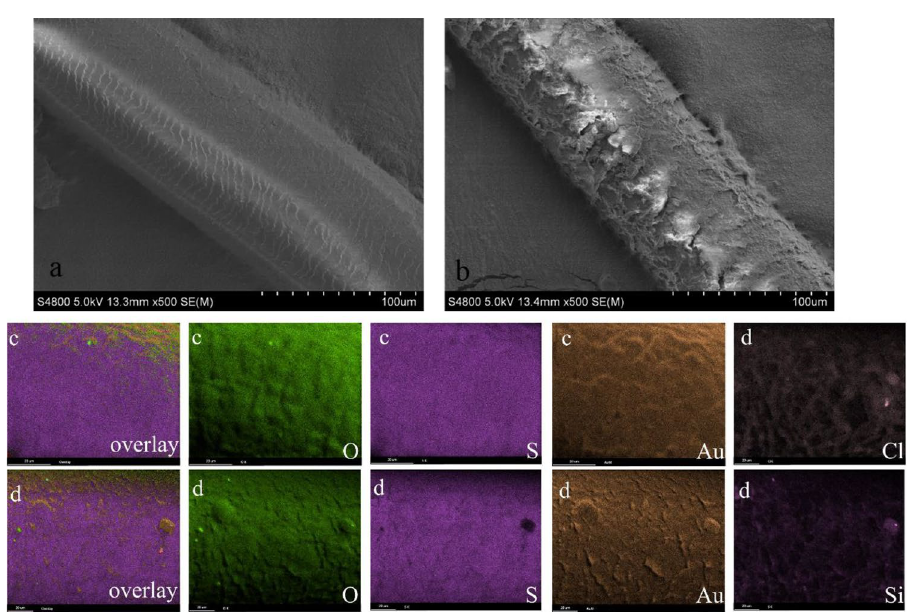
Figure 2. SEM photos of HHF ( a ) and HHF-PODS ( b ). Elemental mapping images of HHF (O, S, Au) ( c ) and HHF-PODS (O, S, Au, Si, Cl) ( d